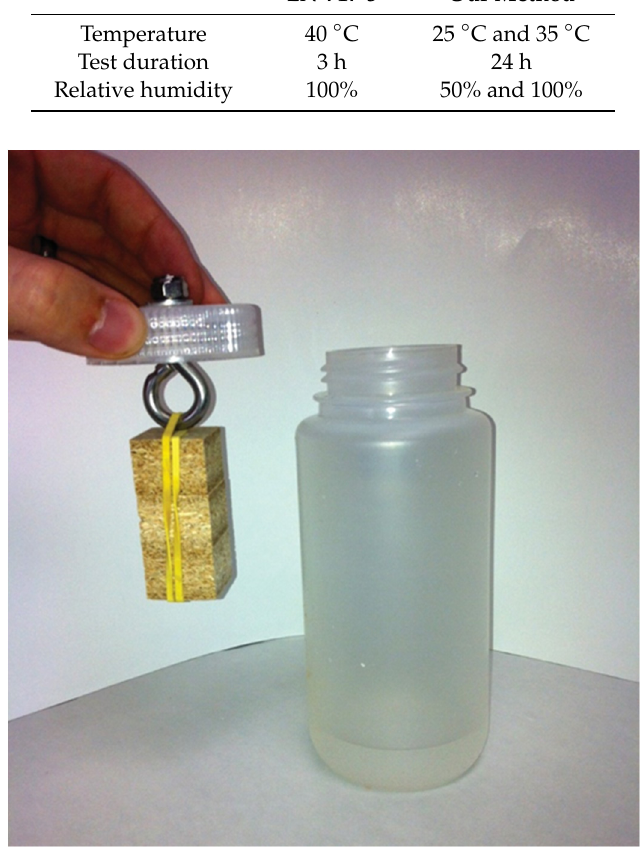
Figure 3. Sample setup for modified EN-717-3 method [44].